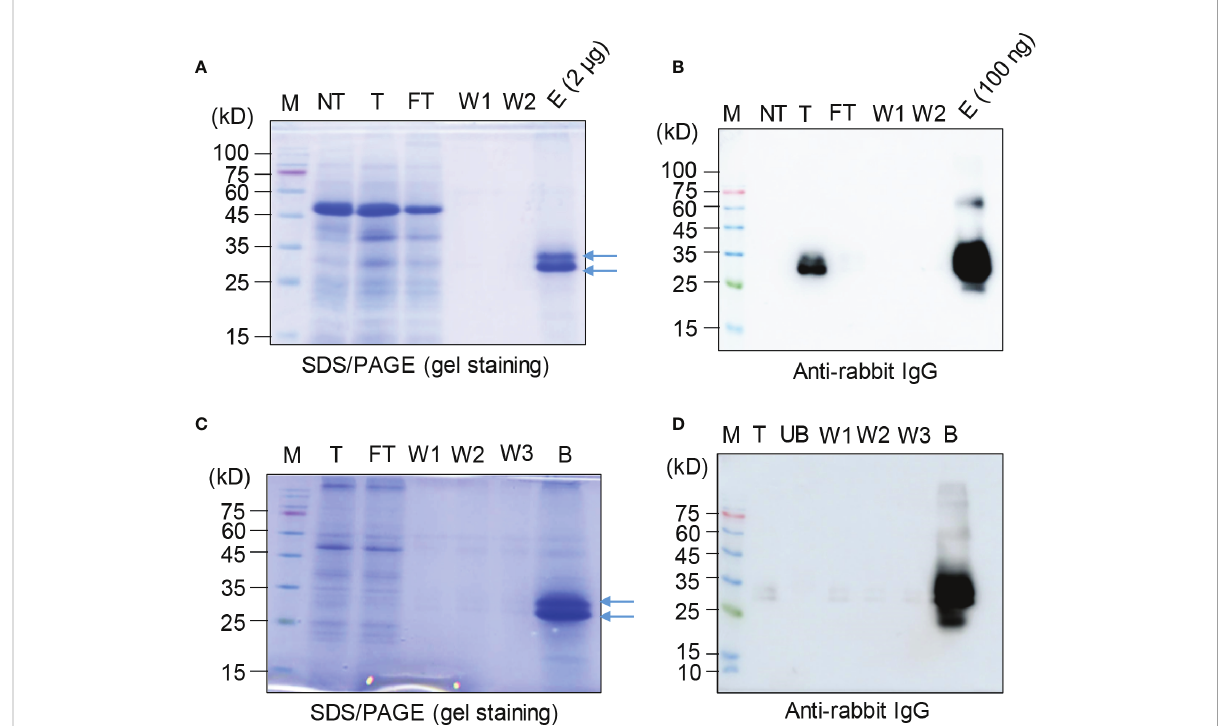
FIGURE 3 Puri fi cation of BGC : Exdn-4 by Ni 2+ -NTA resin and microcrystalline cellulose resin. (A, B) Ni 2+ -NTA-based puri fi cation of BGC : Exdn-4. Leaf tissues harvested at 5 dpi were homogenized in extraction buffer at a 1:6 ratio (w/v). The total protein extracts were loaded into a column containing Ni 2+ -NTA resin at 4°C, allowed to pass through the column due to gravity, and washed fi ve times using washing buffer. Finally, proteins were eluted using 400 mM imidazole. The indicated fractions from puri fi cation were separated by SDS/PAGE and stained by CBB (A) or analyzed by Western blotting using HRP-conjugated anti-rabbit IgG antibody (B) . M, protein size standard; NT, non-transformed wild-type plants; T, total soluble proteins; FT, fl ow-through fraction; W1 and W2, the fi rst and second wash-off fractions; E, eluted fraction. Arrows, BGC : Exdn-4. (C, D) MCC bead-based puri fi cation of BGC : Exdn-4. Total protein extracts from leaf tissues harvested at 5 dpi were mixed with MCC beads followed by washing fi ve times with distilled water. During puri fi cation, total protein extracts (T); unbound fraction (UB); and the fi rst, second, and third wash-off fractions (W1, W2, and W3, respectively) were saved for analysis. The B fraction was prepared by releasing proteins from MCC beads in SDS sample buffer by boiling for 10 min. These samples were separated and analyzed by SDS/PAGE and Western blotting (D)